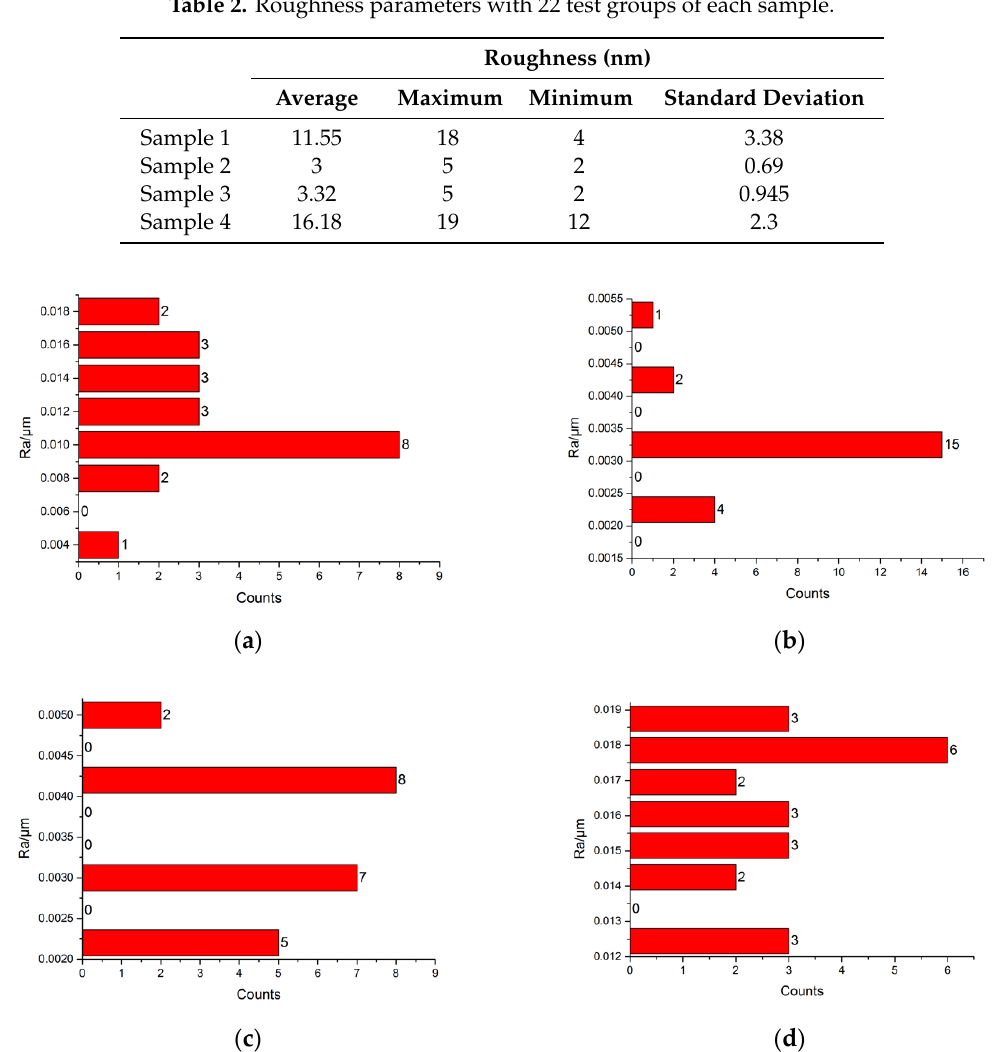
Table 2. Roughness parameters with 22 test groups of each sample.